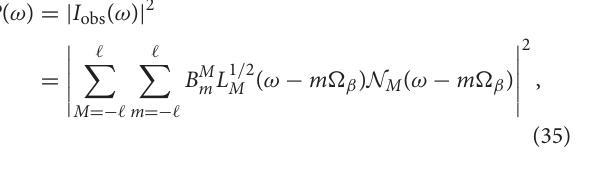
A realization of the power spectrum is given